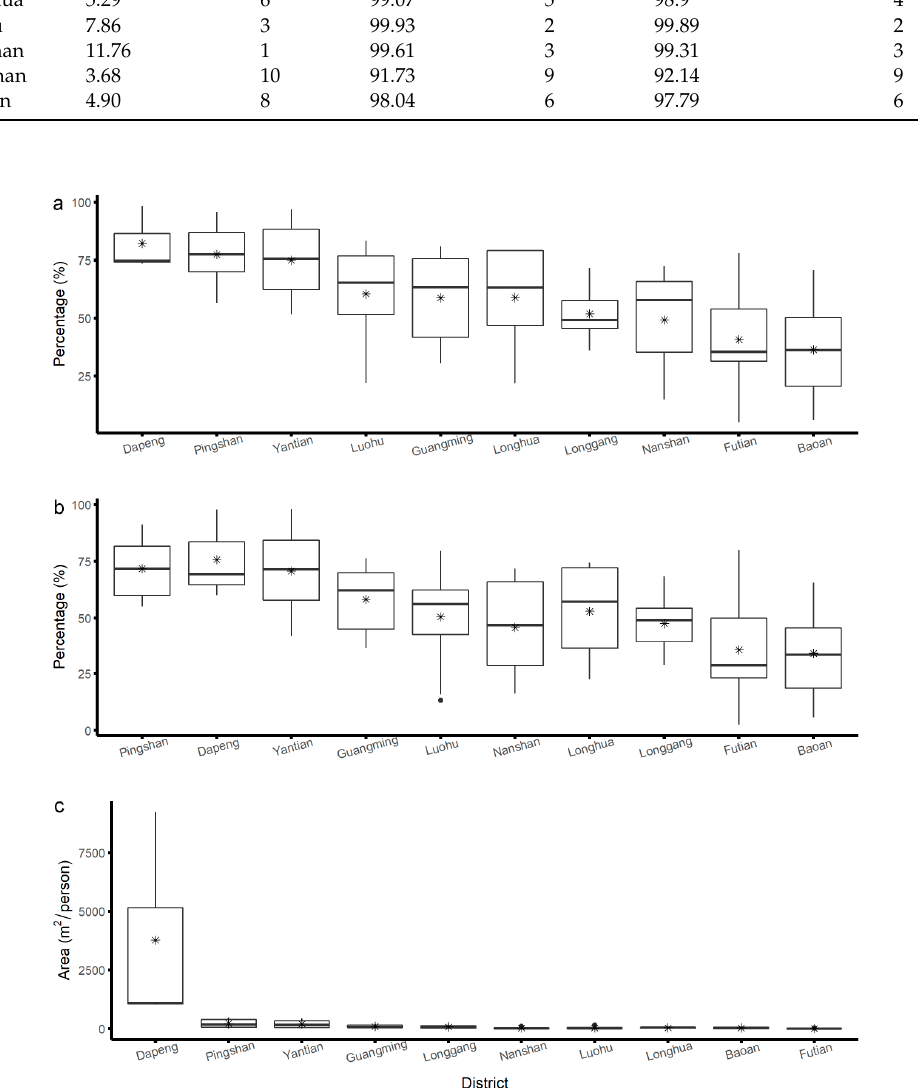
Figure 5. The box plots show the values of green infrastructure indicators at the sub-district level grouped by each district. The districts were ordered according to the rankings at the district level. The lower end of the box represents the first quartile, and the upper end represents the third quartile. The ends of the whiskers represent 1.5 times the interquartile range. The stars are mean values. ( a ) The percentage of residential buildings <300 m to a green space with a minimum size of 1 ha; ( b ) the percentage of WeChat population <300 m to a green space with a minimum size of 1 ha; ( c ) the area of green space per capita.